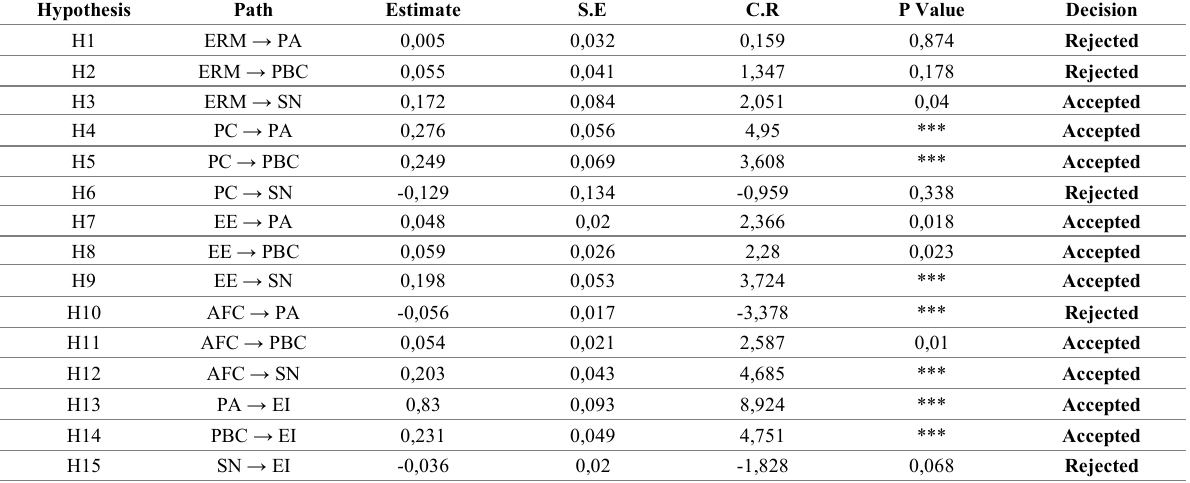
Table 6 : Hypothesis Test